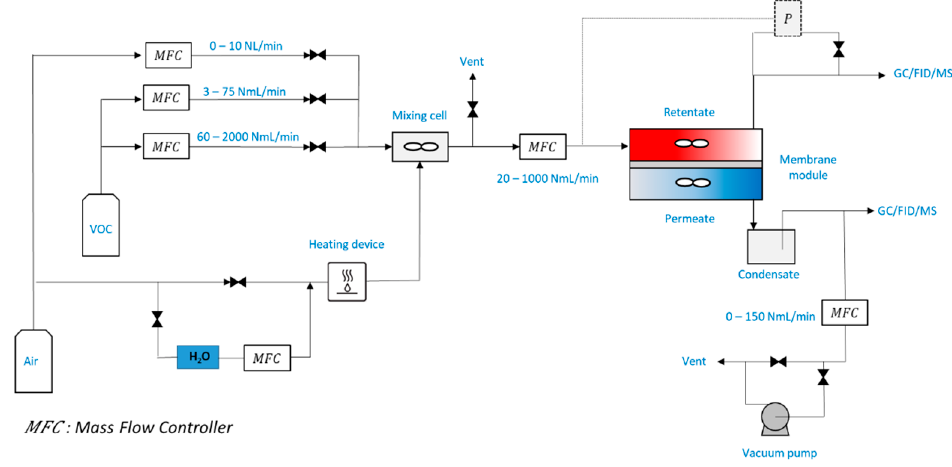
Figure 2. Experimental